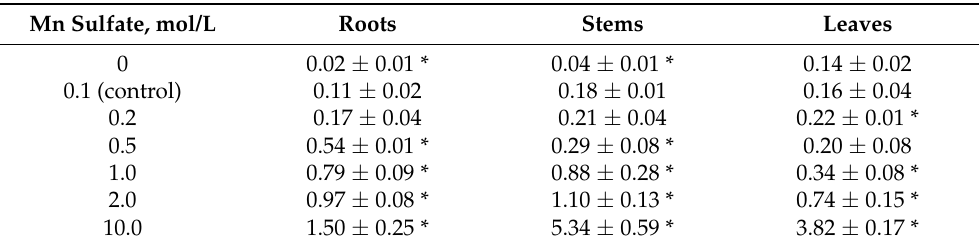
Table 1. The accumulation of Mn (wt% ± SD) in organs of potato plants grown in media with different concentrations of Mn sulfate. Roots Stems